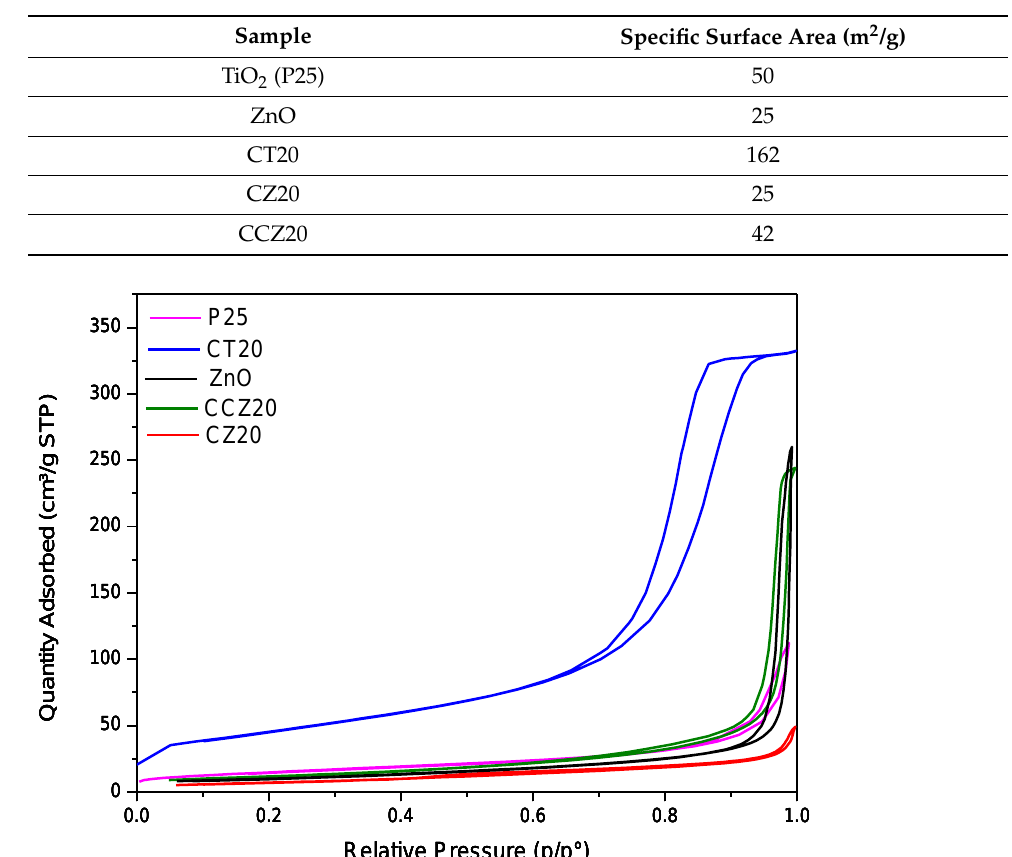
Figure 5. Comparison of N 2 physisorption isotherms of (black) bare ZnO, (blue) P25, (black dash) CZ20, (black dot) CCZ20, and (blue dash) CT20.